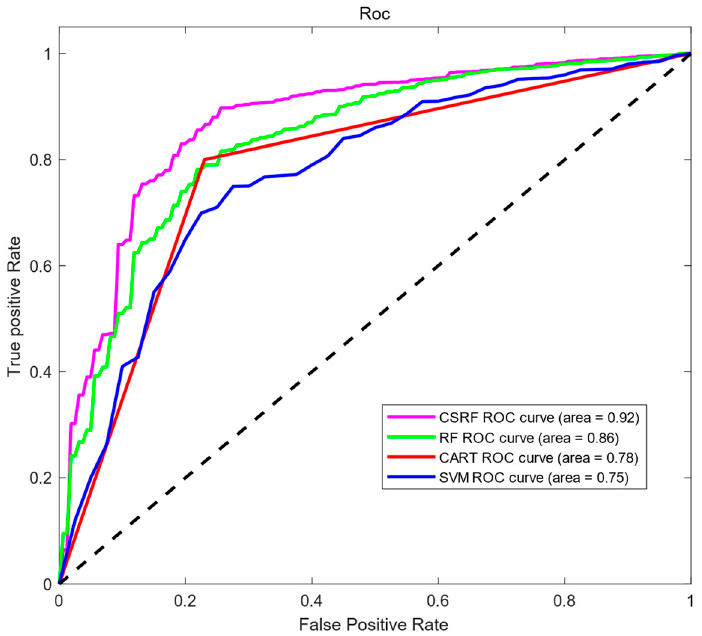
Figure 10. ROC curves of the CSRF model and compared models. Note: The black line is a diagonal line from (0,0) to (1,1).